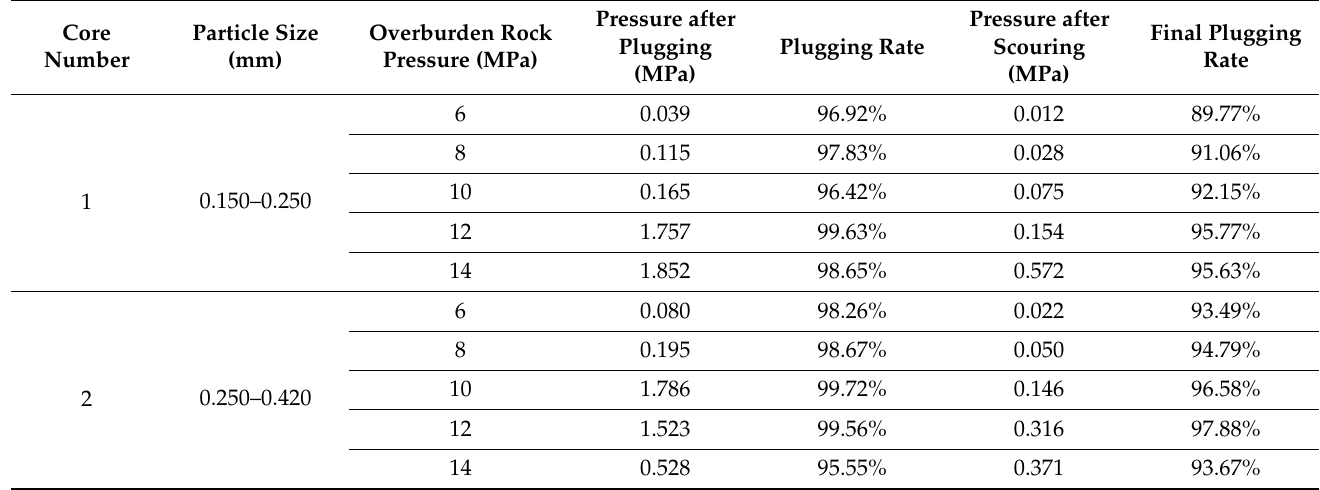
Table 8. Final plugging rate of synergistic system under different overlying rock pressures.